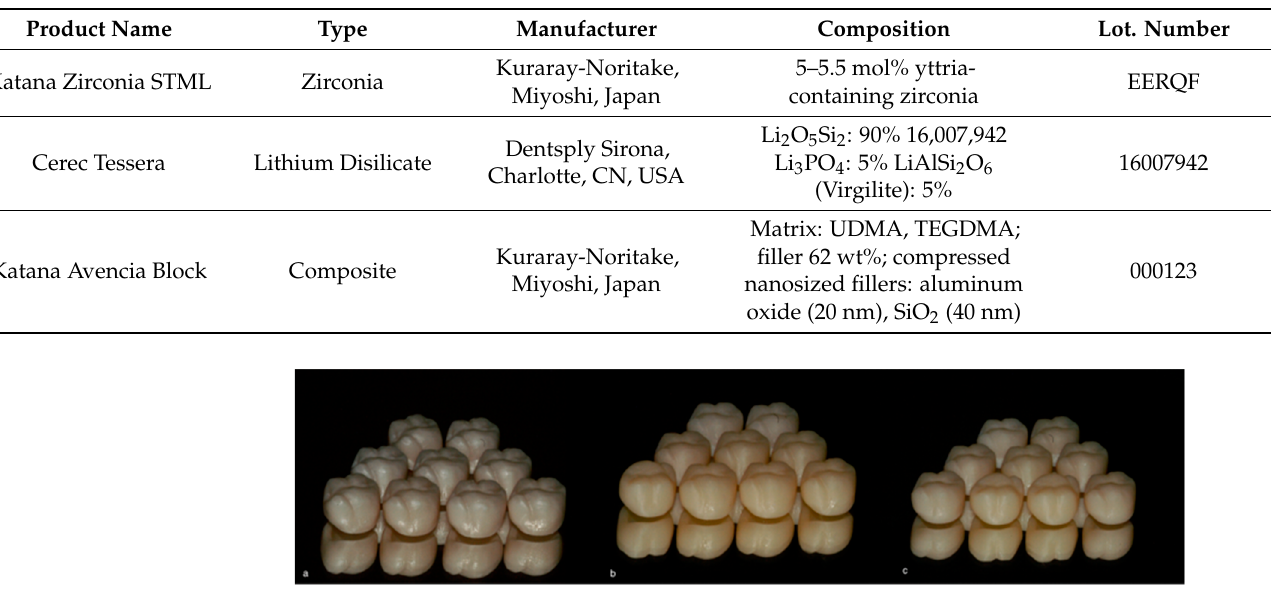
Figure 3. Zirconia ( a ), composite ( b ), and lithium disilicate ( c ) crowns. Table 1. Composition of the investigated